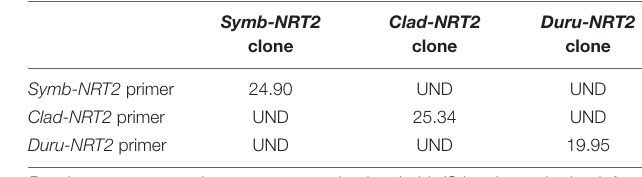
Results are presented as average cycle threshold (Ct) values obtained from reactions between each of the three pairs of primers and the three clones generated, whereby a low Ct value represents a favorable reaction. UND indicates undetermined or no reaction between the specific set of primer and the clone.